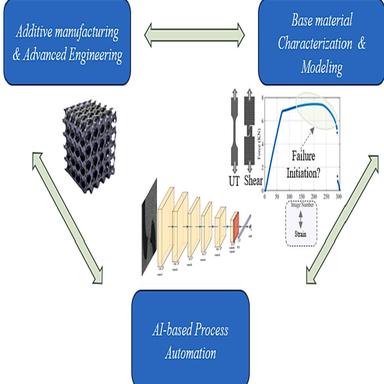
Additive manufacturing and advanced engineering requires the characterization and modeling of the base material properties, whose experimental testing assessment can be automated with the use of appropriately designed artificial intelligence models.